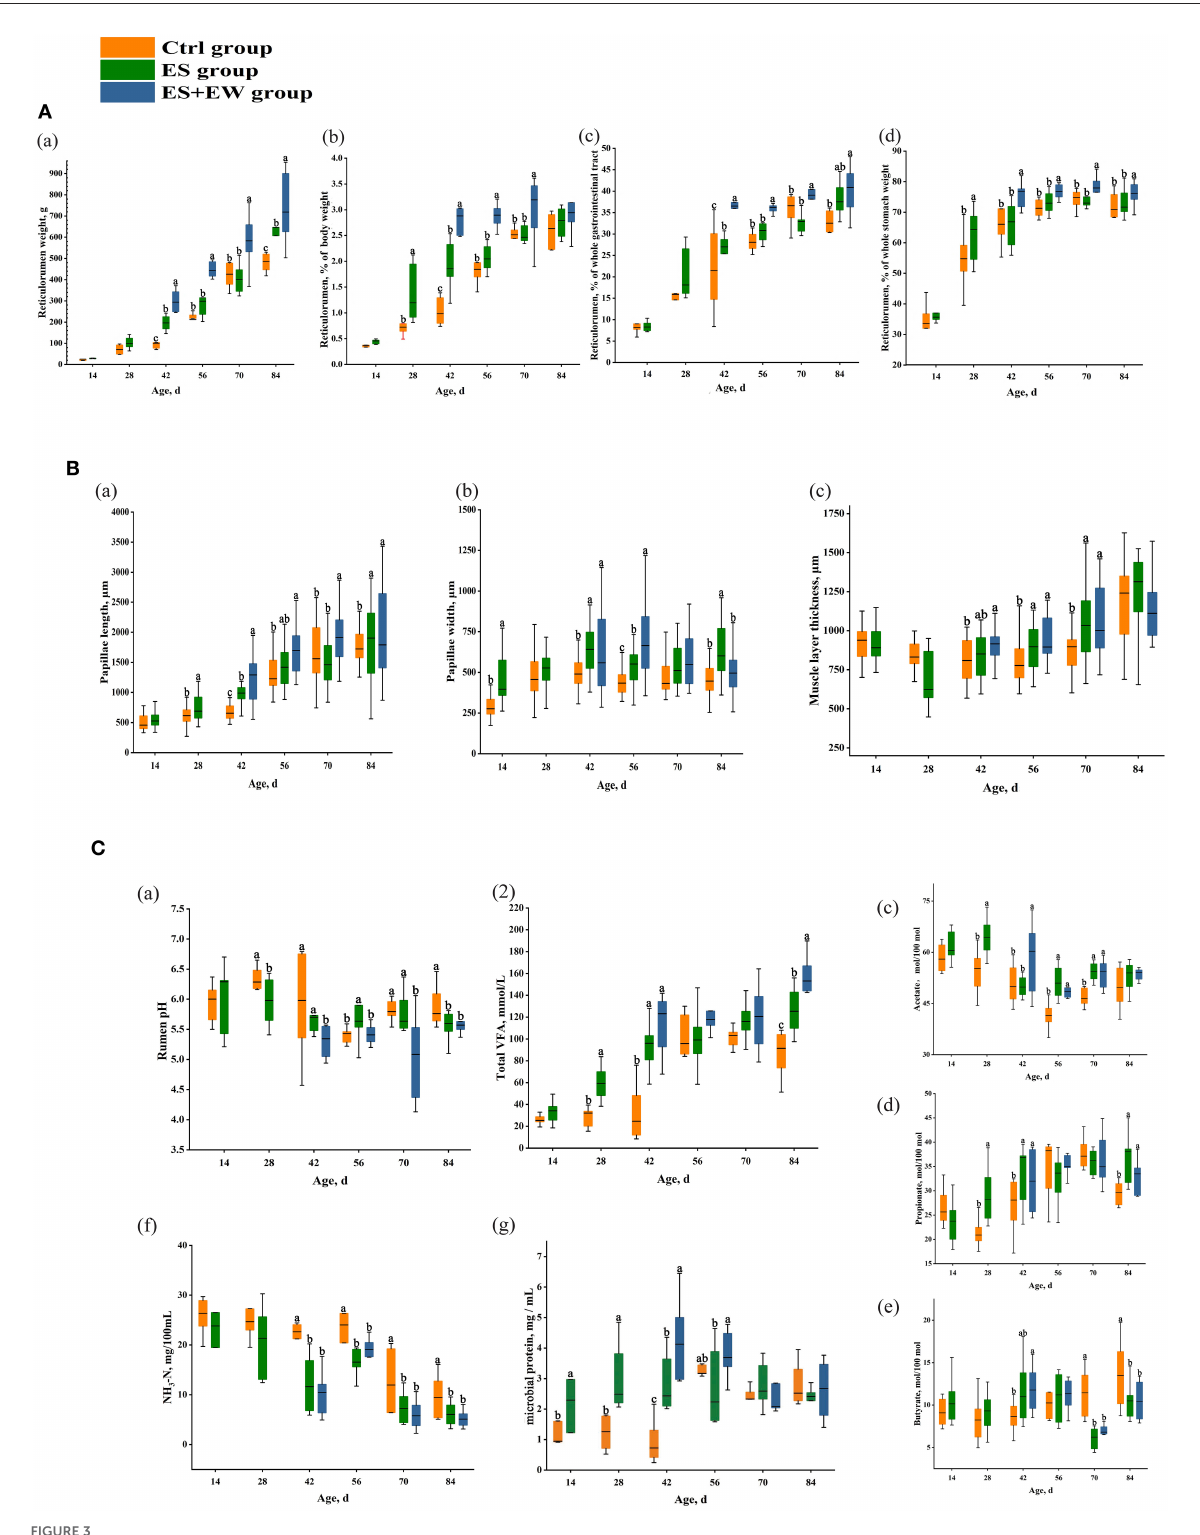
FIGURE3 The development of lamb ruminal anatomy (A) , morphology (B) , and fermentation (C) in different early feeding strategies. Boxes with different letters at a single time point indicate means that differed based on the means separation ( P < 0.05). Error bars indicate SEM for the treatment × age